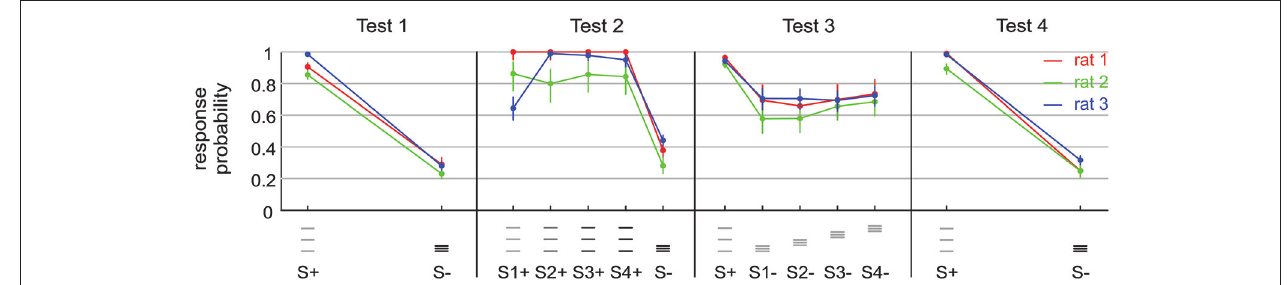
FIGURE 3 | Exposing a small capability of rats to discriminate spatial frequency . Test 1 presented stimuli containing frequency and amplitude cues (S + : af; S − : AF). Test 2 presented the same stimuli (S1 + : af; S − : AF) but also amplitude matched ones (S4 + : 4af = Af), as well as intermediate stimuli (S2 + : 2af; S3 + : 3af). Note that FA rate increased a bit, but Af/AF discrimination is comparable to af/AF discrimination in this context. Test 3